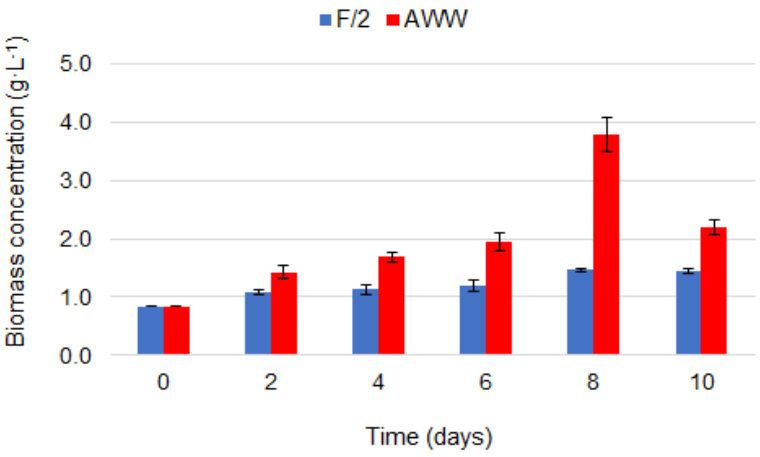
Figure 3. Changes observed in the biomass concentration during the cultivation of Monoraphidium sp. (mean ± SD; F/2—synthetic medium, AWW—aquaculture wastewater).